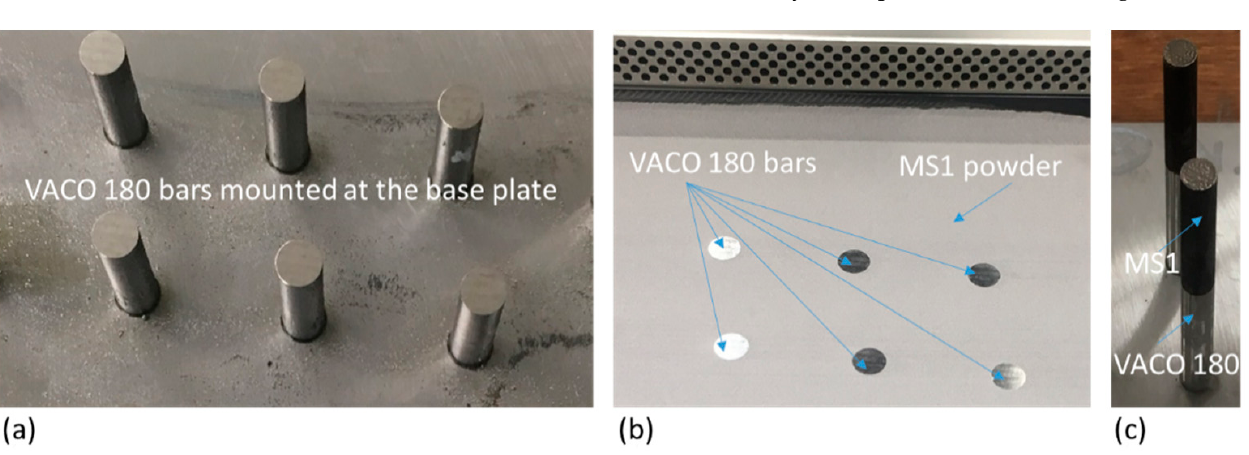
Figure 2. Additive manufacturing process: ( a ) VACO 180 bars mounted at the base plate after grinding; ( b ) printing chamber filled by MS1 powder up to the top bases of VACO 180 bars ready for additive manufacturing; ( c ) finished parts (still mounted at the base plate).